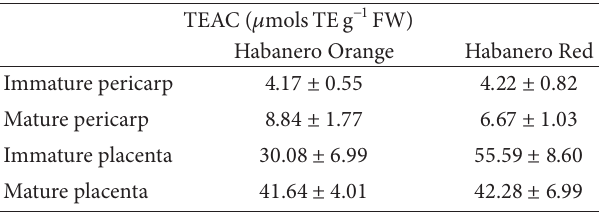
Values represent mean ( 𝑛 = 3 ) ± SD.